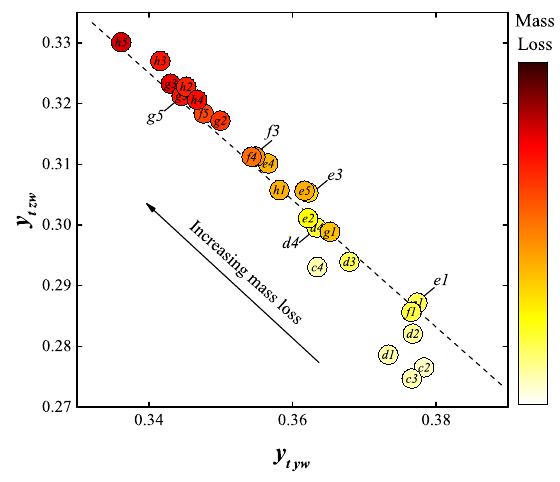
Figure 12. Secondary chromatic parameter map of y tyw vs. y tzw